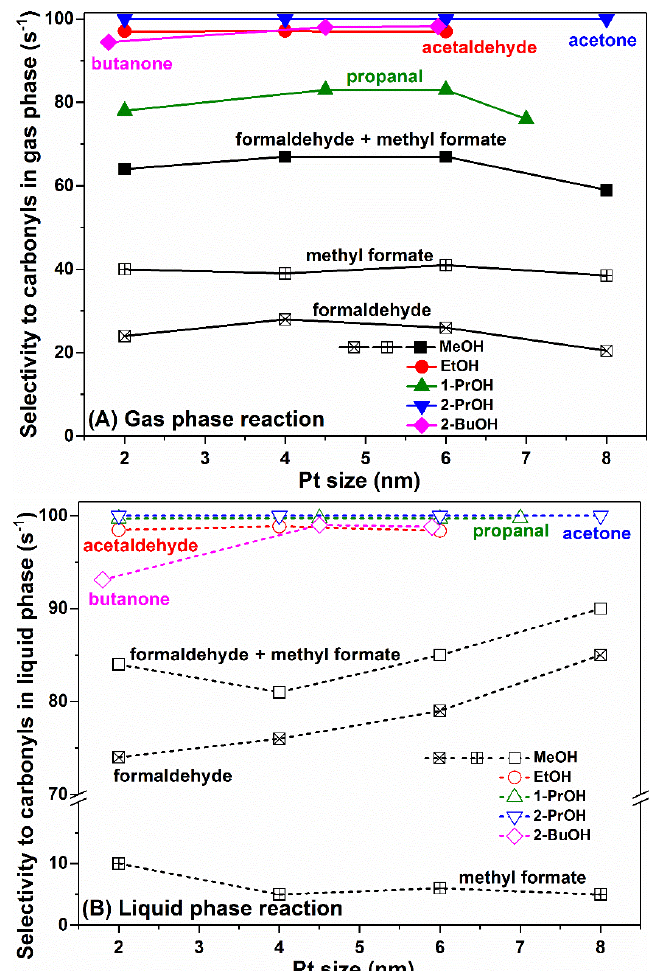
Figure 3. Size effect of Pt nanoparticles on product selectivity to carbonyl compounds (other than CO 2 ) of MeOH, EtOH, 1-PrOH, 2-PrOH oxidation at 60 ◦ C and 2-BuOH oxidation at 80 ◦ C. ( A ) Gas